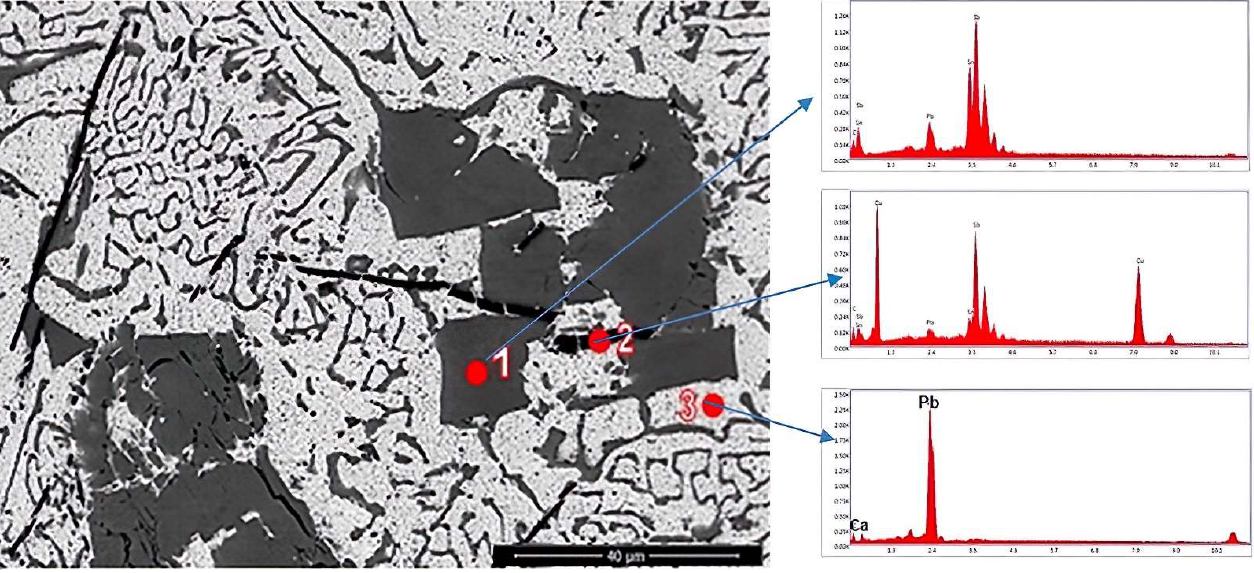
Figure 3. EDS analysis in points 1, 2 and 3 for the sample YP1.